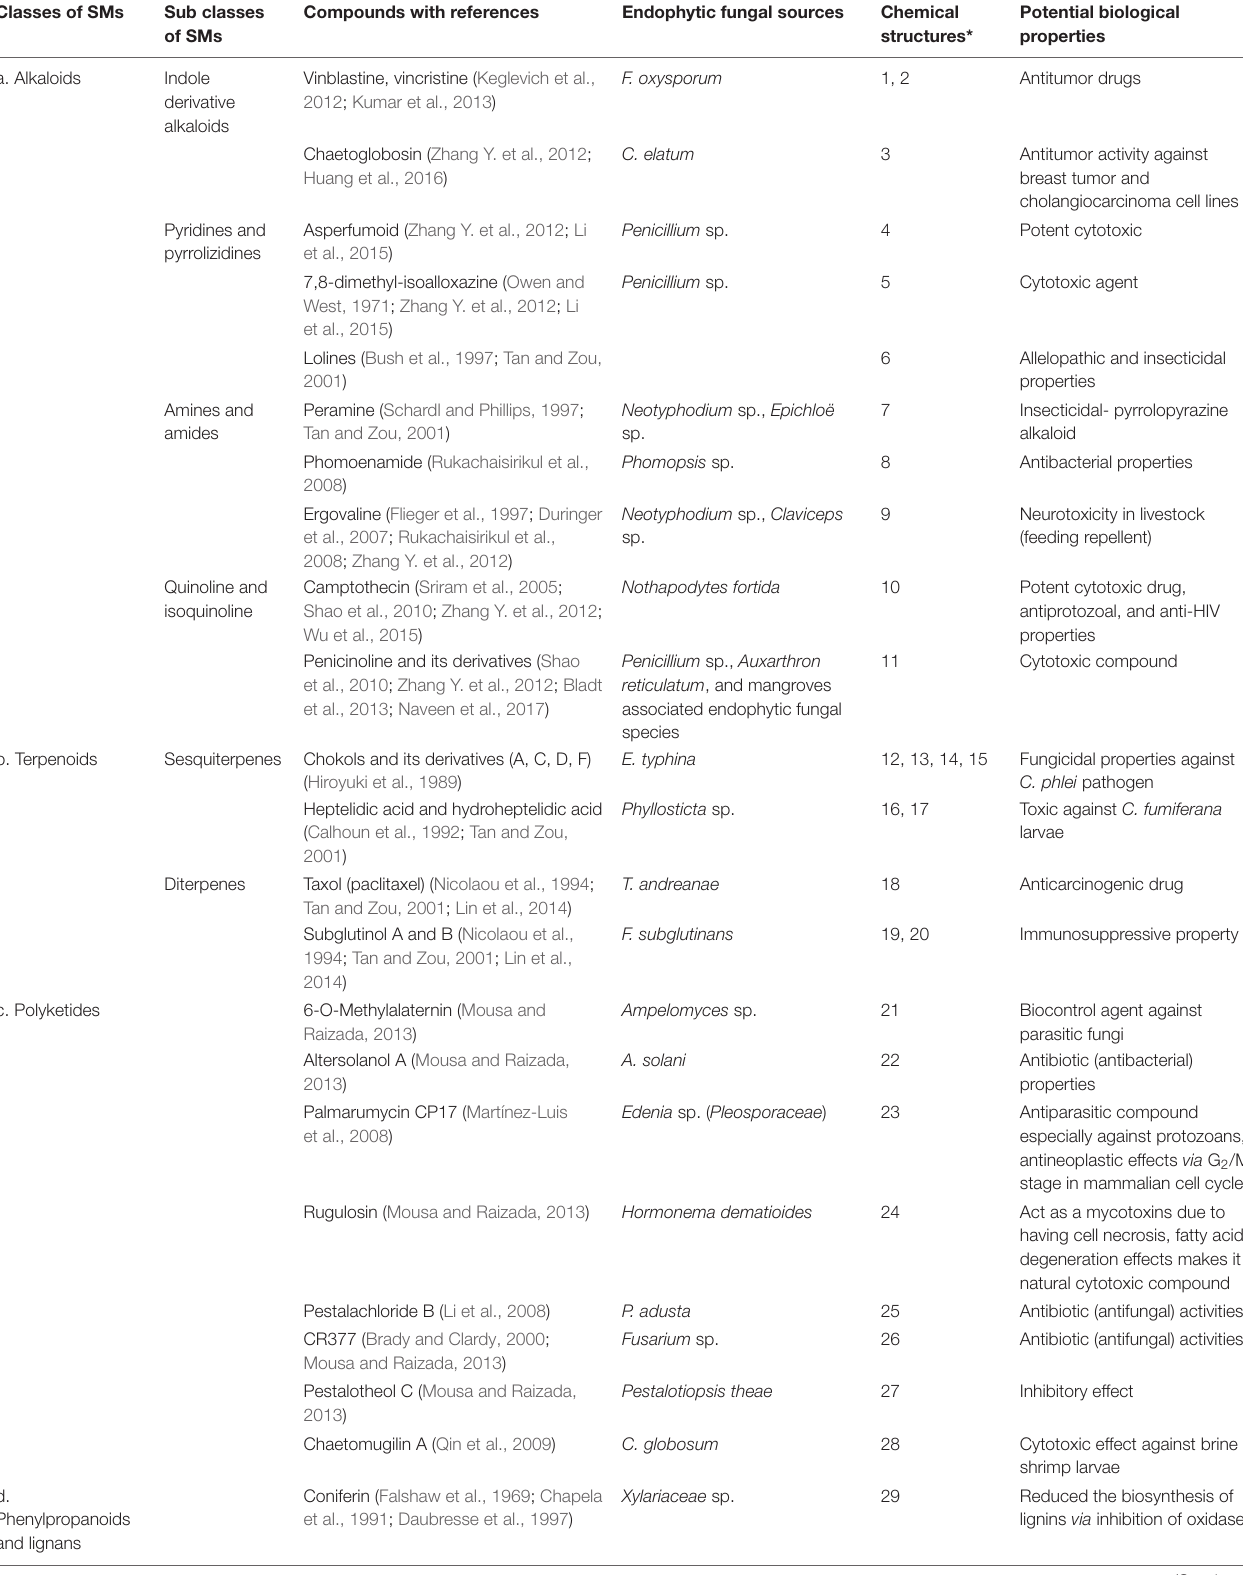
TABLE 5 | Classes of endophytic fungal secondary metabolites (SMs) with biological potential